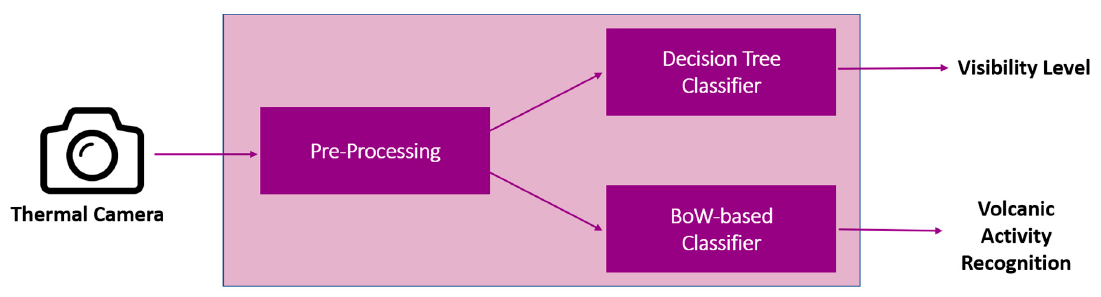
Figure 3. The scheme of the machine learning classifier of thermal images composed of 3 tasks: (i) preprocessing; (ii) decision tree classifier; and (iii) BoW-based classifier.